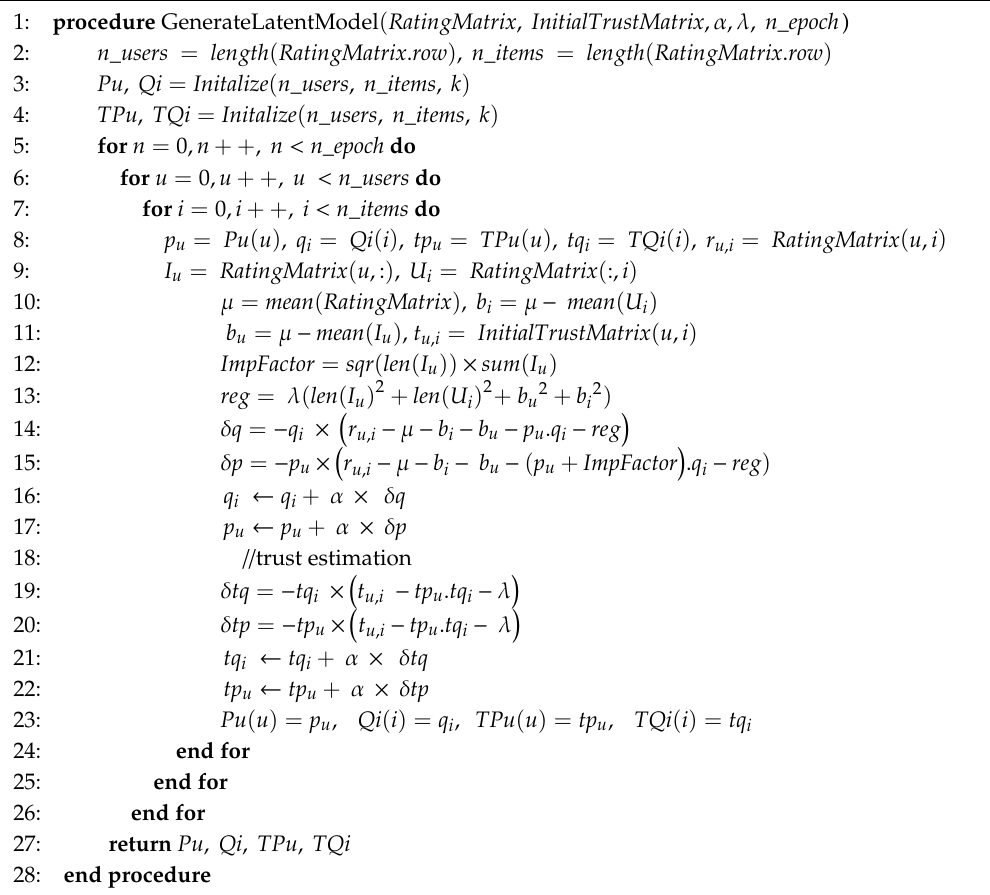
Algorithm 2 Pseudocode for latent vector